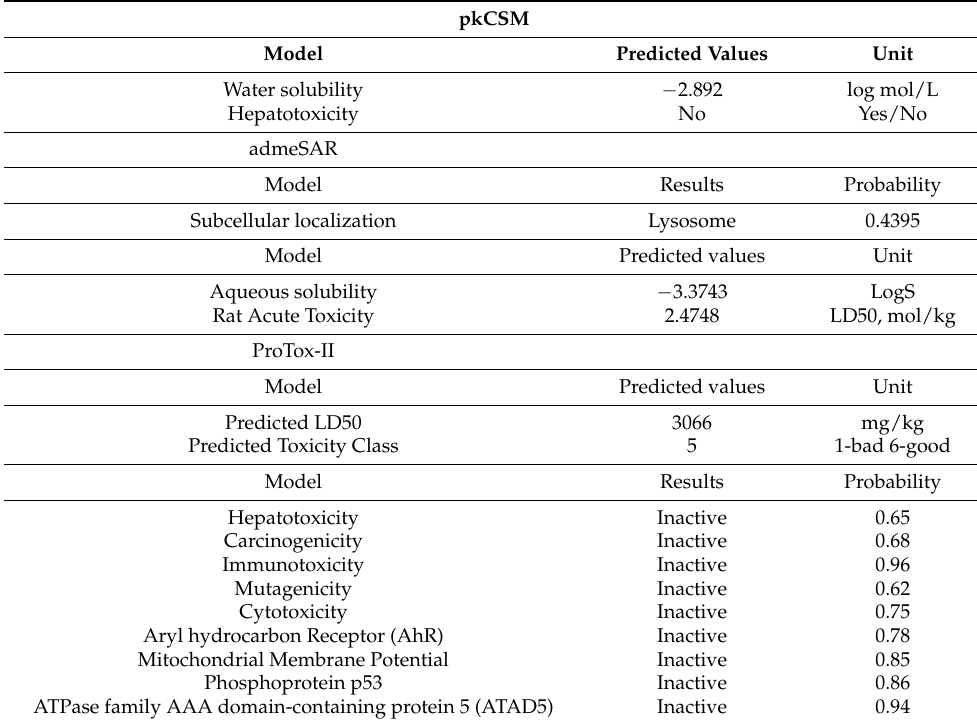
Table 5. Toxicity predictions for TPPS4, using admeSAR pkCSM and ProTox-II webservices.